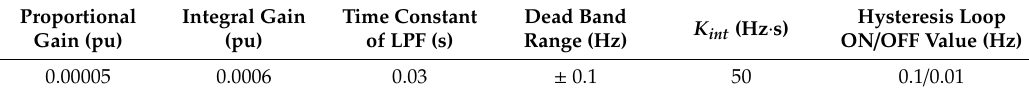
Figure 3. Proposed frequency deviation signal generator. Table 3. Parameters used in Figures 2 and